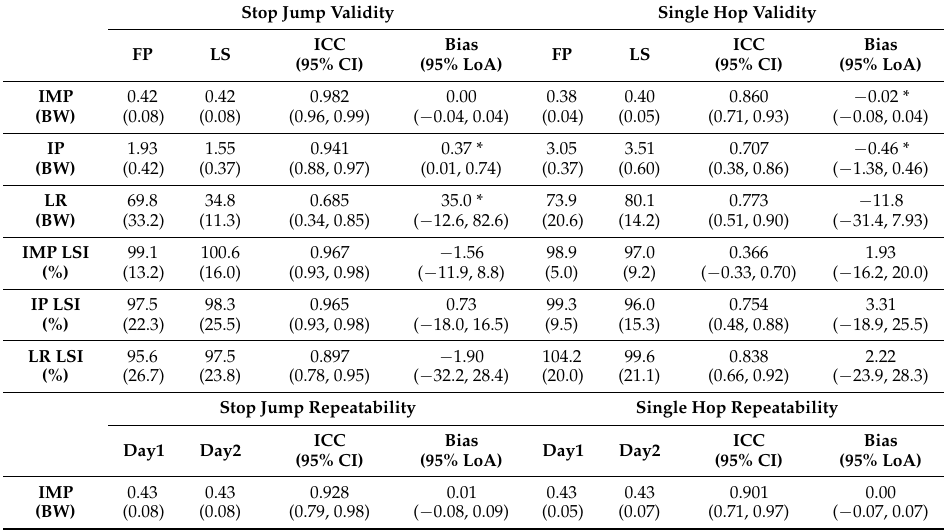
Table 1. Validity and repeatability of loadsol insole sensors during the stop jump and single hop tasks, collected at 100